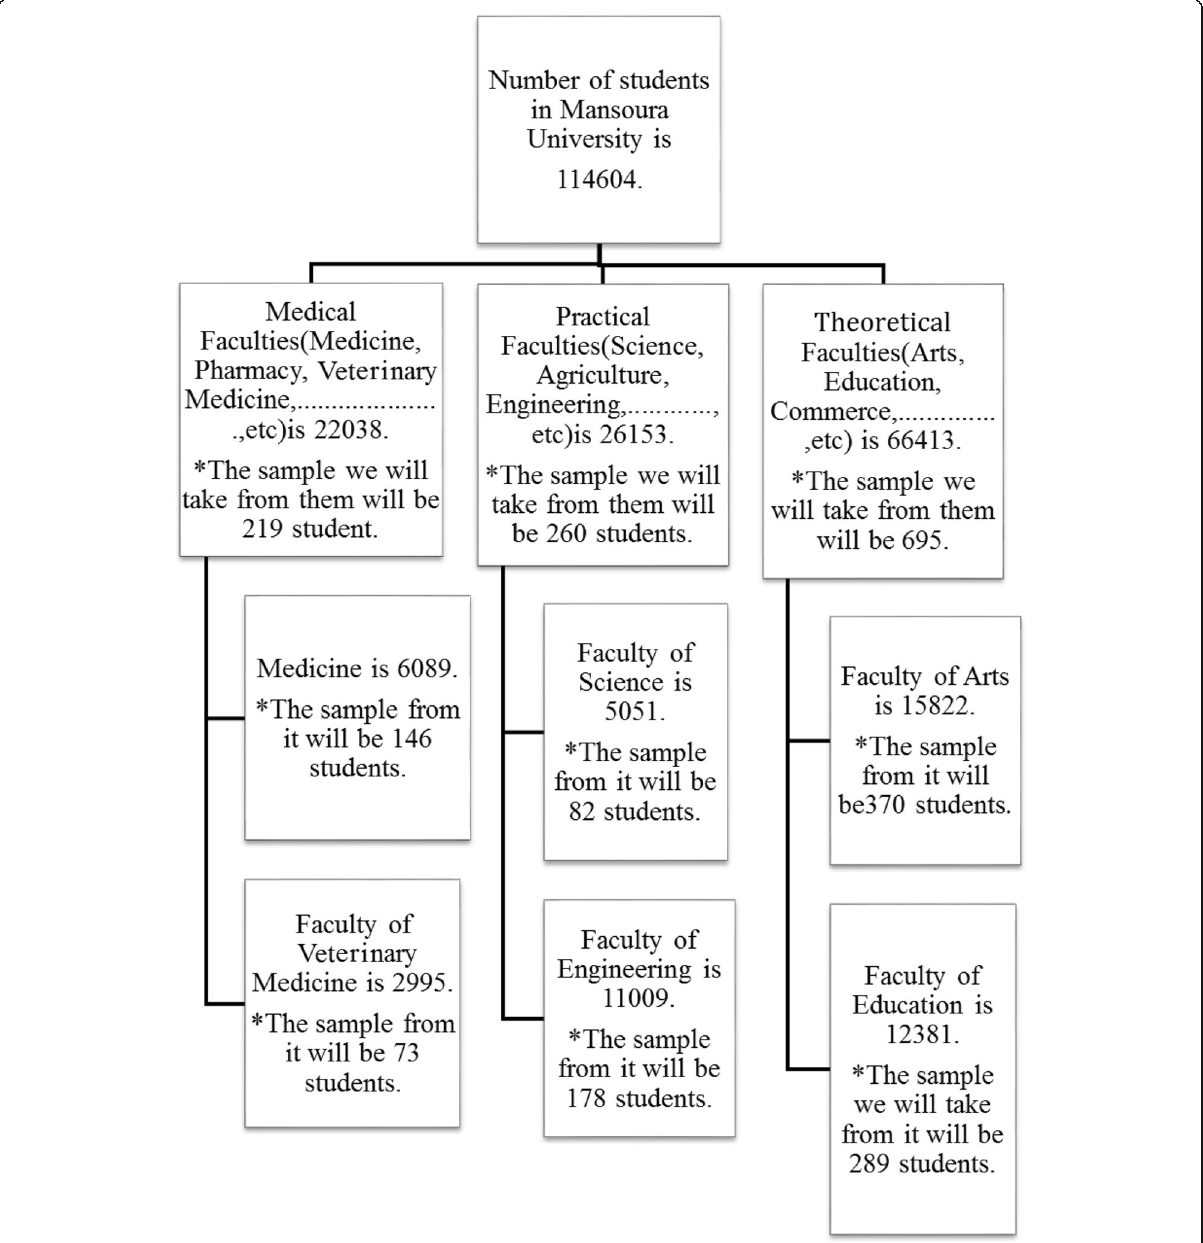
Fig. 1 Sample size among the different college